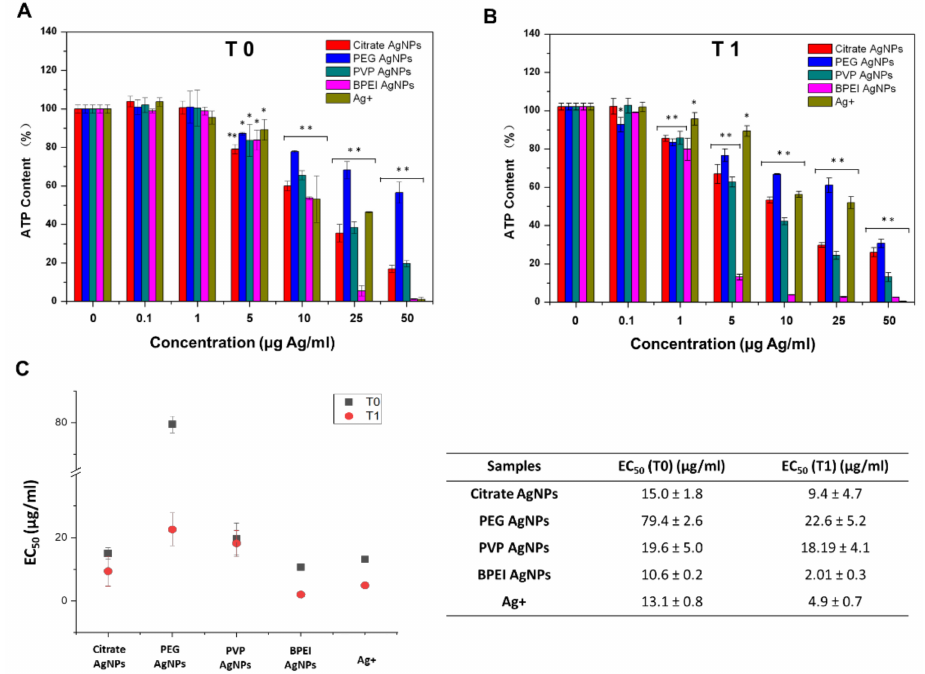
Figure 4. Dynamics of AgNPs’ toxicity to Hepa1c1c7 cells. Data obtained from luminescent assay for silver nanoparticles in Hepa1c1c7 cells 24 h. ( A ). The toxicity of the pristine AgNPs to Hepa1c1c7 cells. ( B ) The toxicity of stored one-year AgNPs in lab to Hepa1c1c7 cells. The y -axis represents the percent